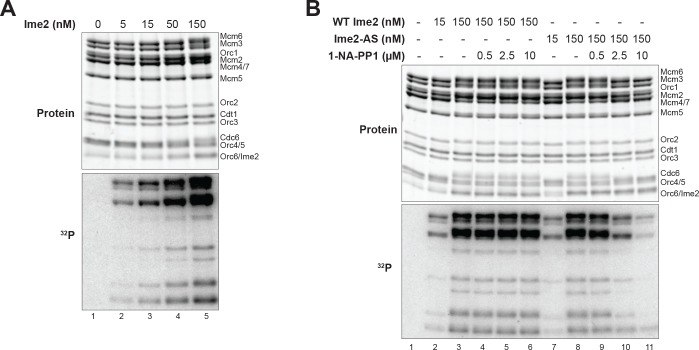
Ime2 kinase activity correlates with inhibition of helicase loading.(A) Increased Ime2 concentration causes increased phosphorylation of the helicase–loading proteins. Top: total protein (Krypton stain). Bottom: phosphorylated protein (modified with [γ-32P] ATP). (B) In vitro kinase assay with wild-type Ime2 and Ime2–AS, with a titration of 1–NA–PP1. Ime2–AS kinase activity wasinhibited by increasing 1–NA–PP1 concentration (lanes 7–11), but wild-type Ime2 kinase activity was not (lanes 2–6). Top: total protein (Krypton stain). Bottom: phosphorylated protein (modified with [γ-32P] ATP).